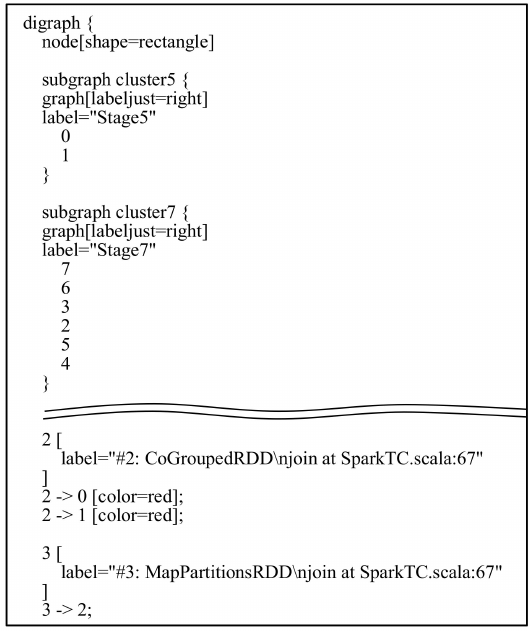
Figure 2. Data structure in the dot file of a profiled SparkTC